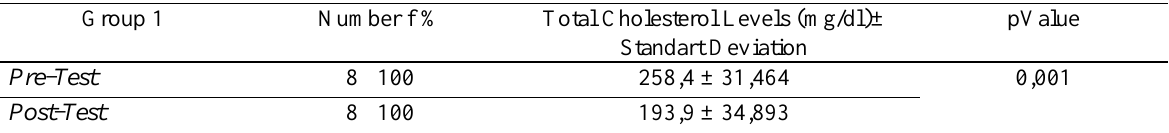
Table 1. Average total blood cholesterol levels before and after treatment in group 1 Group 1